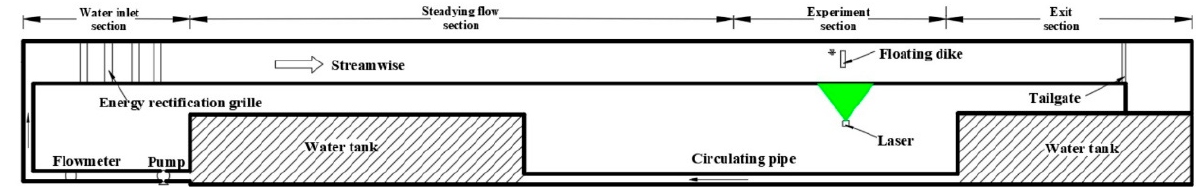
Figure 2. Experimental setup in the flume.